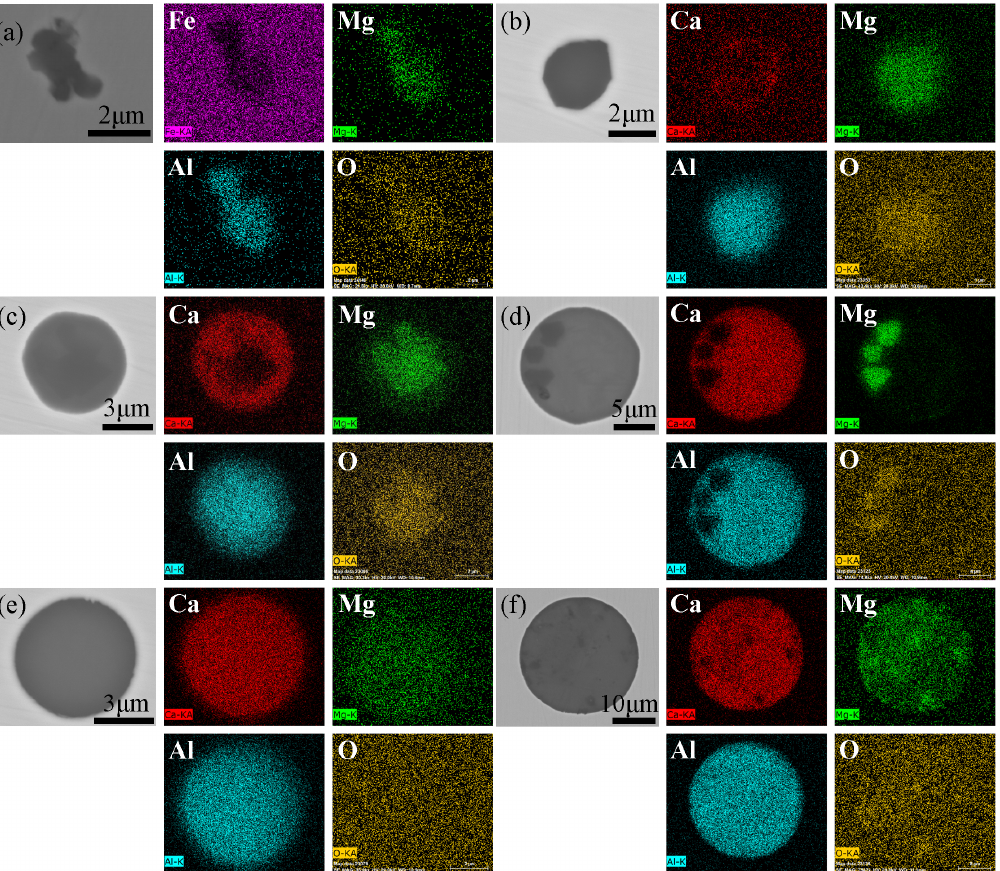
Figure 3. Elemental mapping of typical inclusions in samples: ( a ) a typical MgO-Al 2 O 3 inclusion in sample 1; ( b ) a typical MgO-Al 2 O 3 inclusion in sample 2; ( c ) a typical CaO-MgO-Al 2 O 3 inclusion in sample 3; ( d ) a typical CaO-MgO-Al 2 O 3 inclusion in sample 4; ( e ) a typical CaO-MgO-Al 2 O 3 inclusion in sample 5; ( f ) a typical CaO-MgO-Al 2 O 3 inclusion in sample 6.